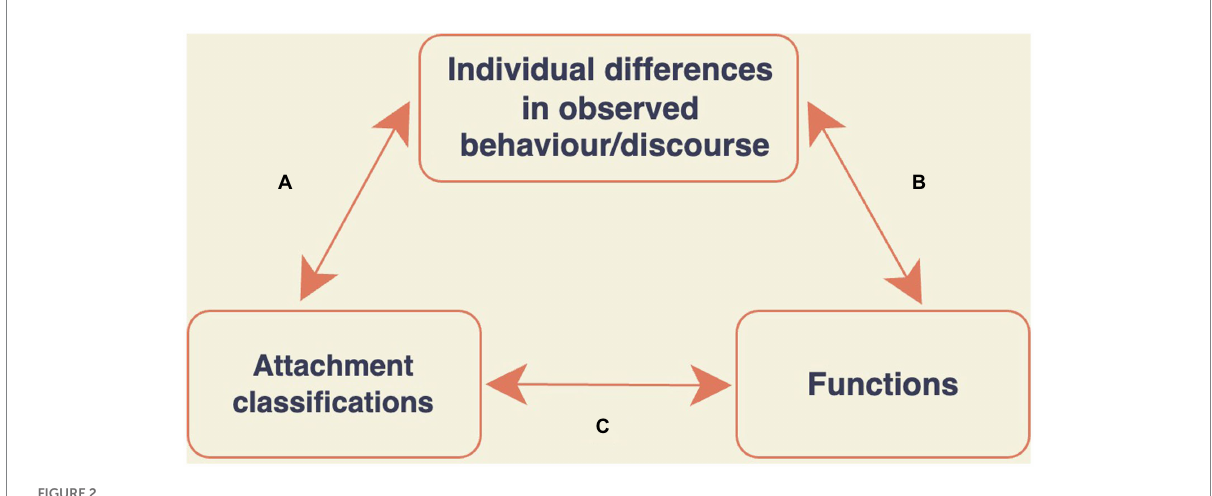
FIGURE 2 The guess and uncover method modified by Talia et al.